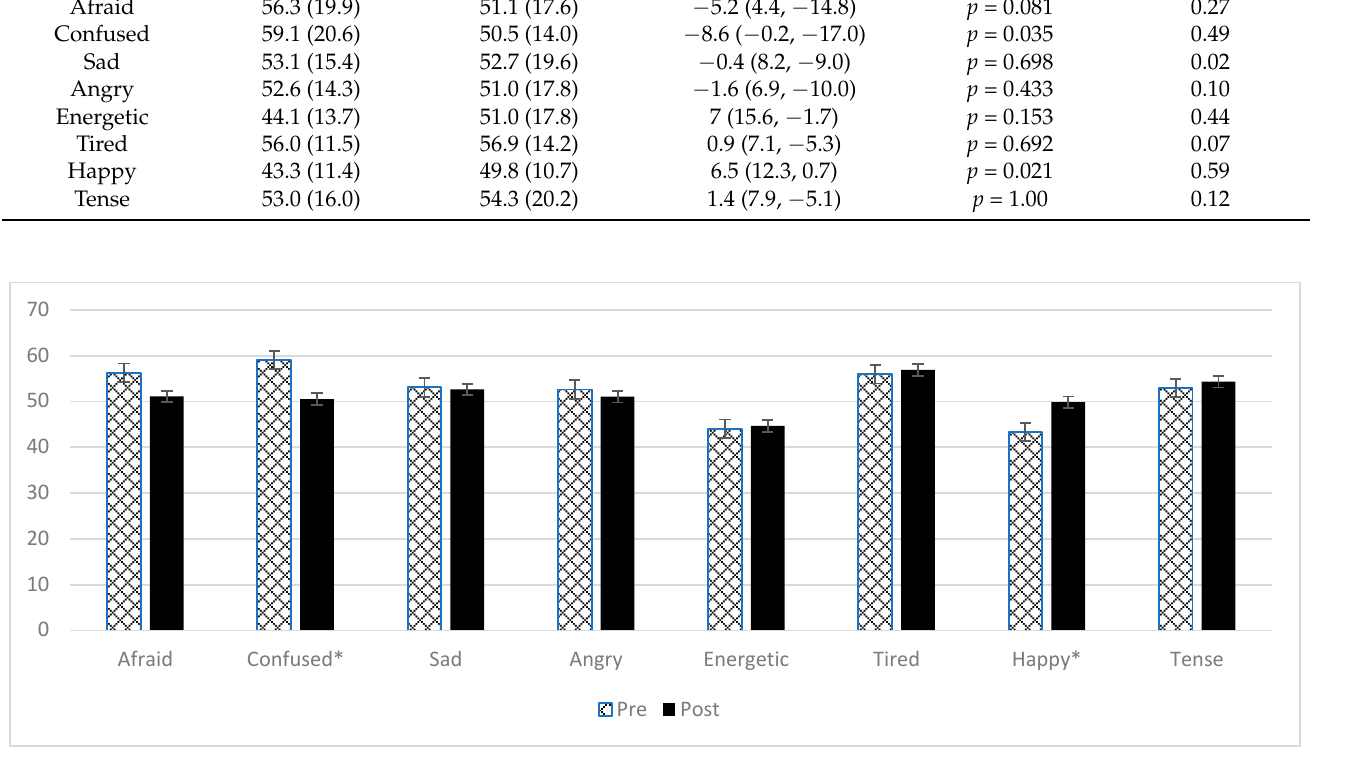
Figure 2. VAMS scores pre and post a single NMT session. Mood states marked with * show a statistically significant change.